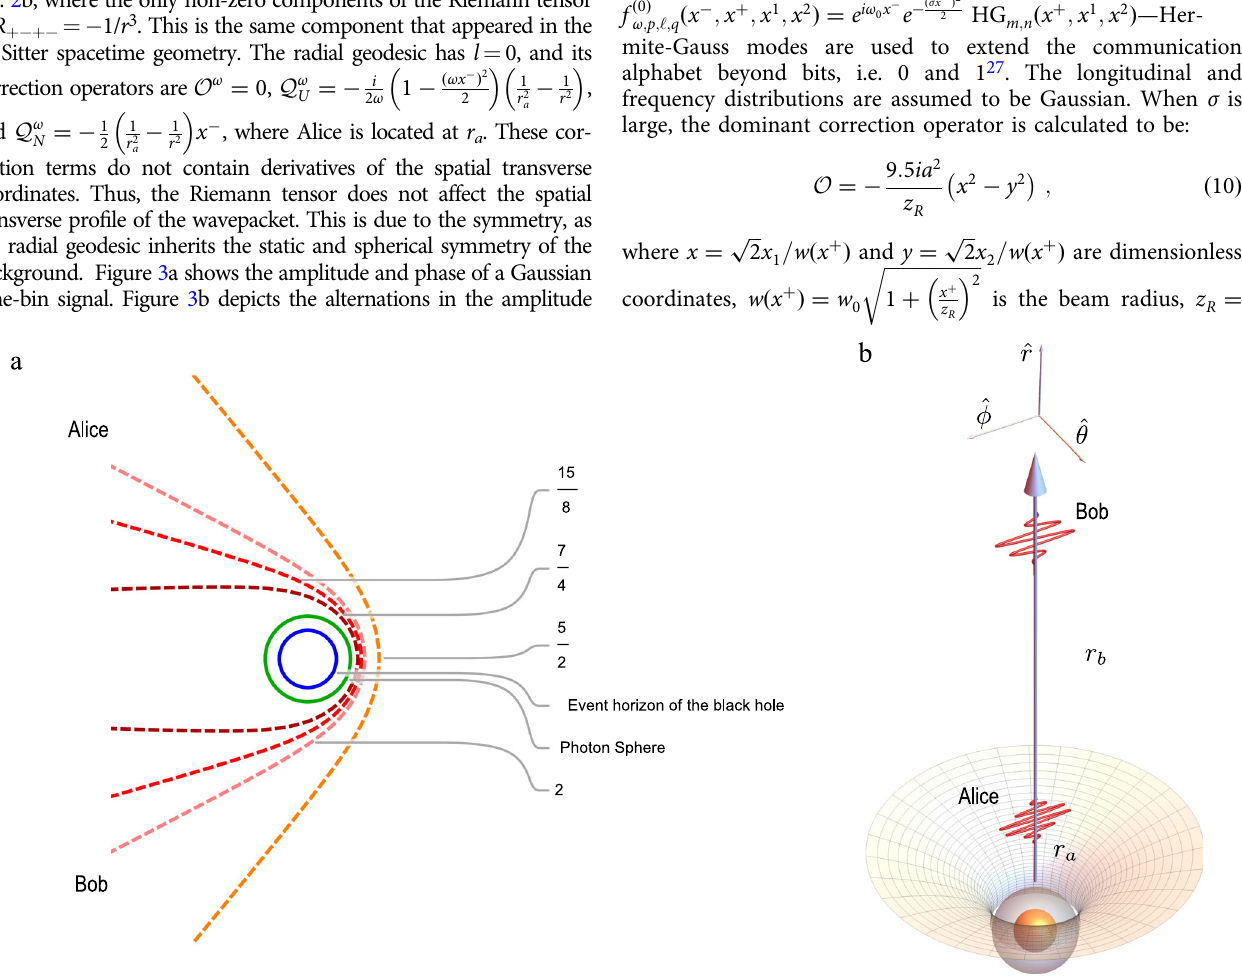
Fig. 2 Propagation of wavepacket and associated null geodesics in the Schwarzschild spacetime geometry. a The null geodesics (dashed curves) for beams that propagate very close to the event horizon — we set the event horizon at 1. b Schematic of wavepacket propagation radially in the Schwarzschild spacetime geometry. Alice and Bob are located at r a and r b , respectively, while θ and φ are polar and azimuthal angles of the standard spherical